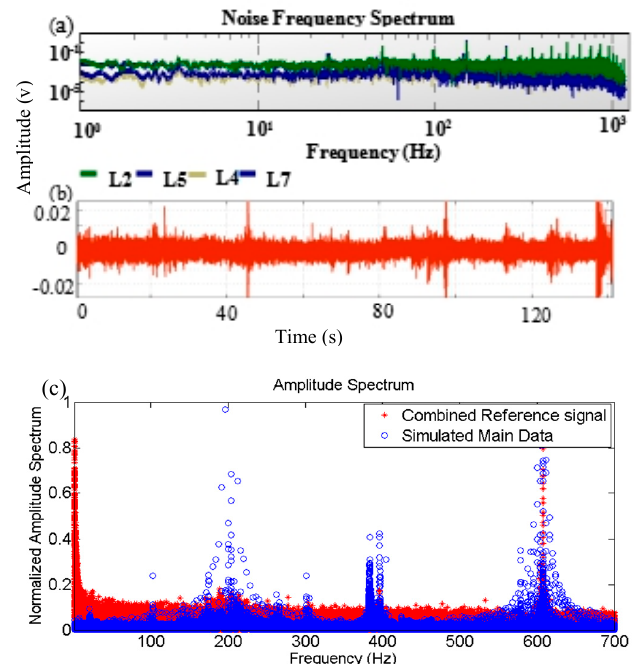
Figure 15. Electromagnetic telemetry noise characteristics and generated synthetic signal: ( a ) frequency spectrum of measured noise data, ( b ) synthetic EM telemetry data and ( c ) normalized amplitude spectrum of the main and the reference signals. The synthetic EMT data are used as the main signal (input data) in the multi-channel adaptive noise canceling system.